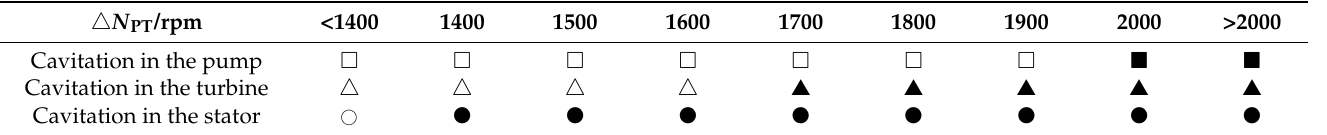
Table 3. The cavitation occurrence inside the torque converter under various △ N PT.